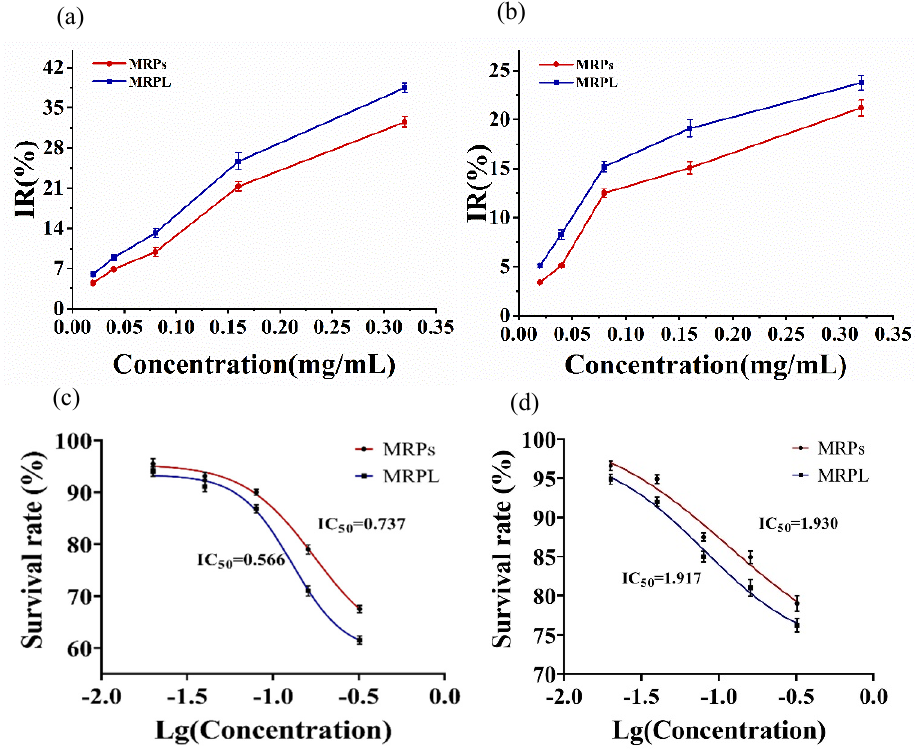
Figure 4. Cytotoxicity to MKN ‐ 28 and HepG ‐ 2 cells. ( a ) Inhibitory effect of free MRPs and MRPL on MKN ‐ 28 cells; ( b ) Inhibitory effect of free MRPs and MRPL on HepG ‐ 2 cells; ( c ) IC 50 values of MRPs and MRPL on MKN ‐ 28 cells; ( d ) IC 50 values of MRPs and MRPL on HepG ‐ 2 cells.